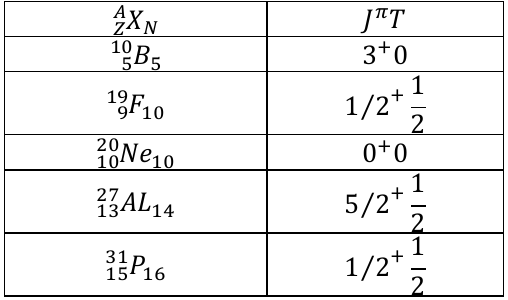
, for stable nuclei under study [28].